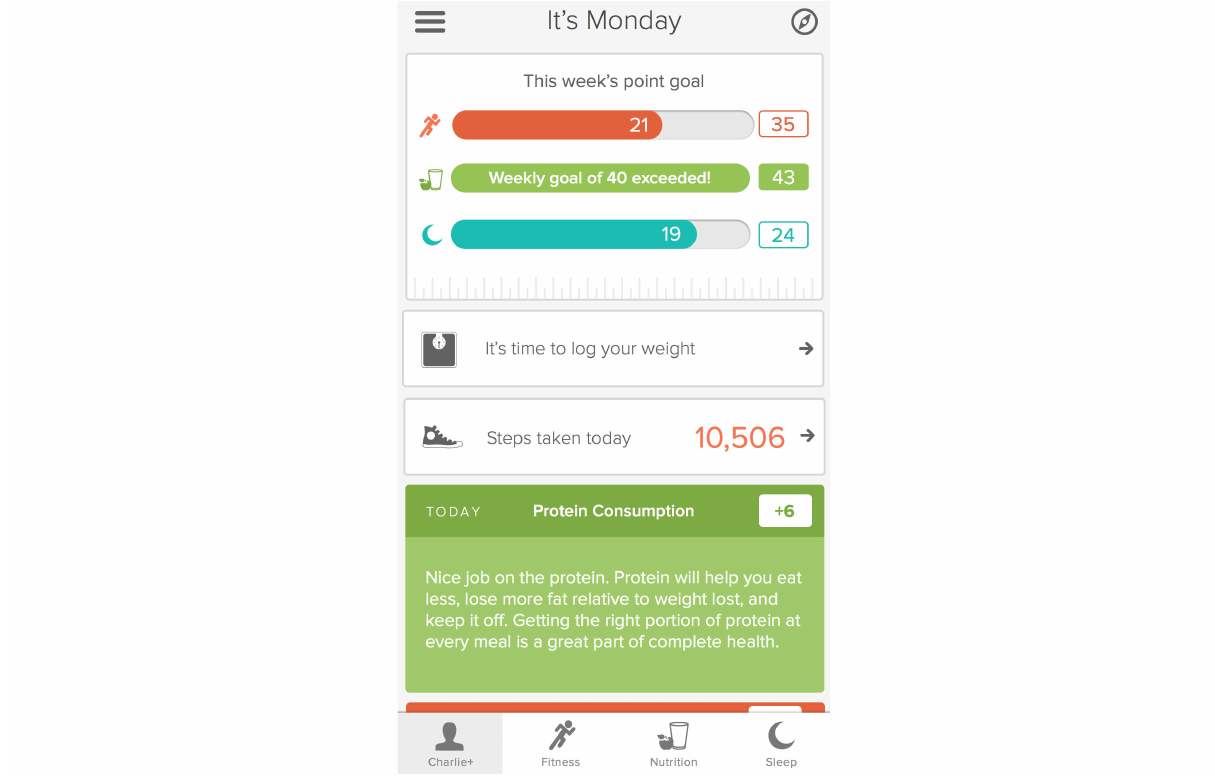
Figure 1. Sample profile screen and